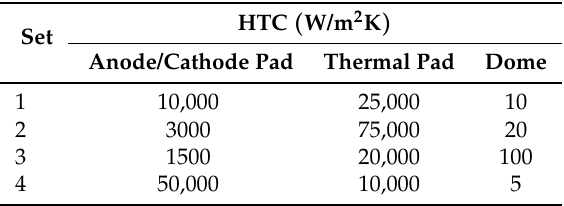
Table 1. HTC training sets used to generate training data for the LED CTM